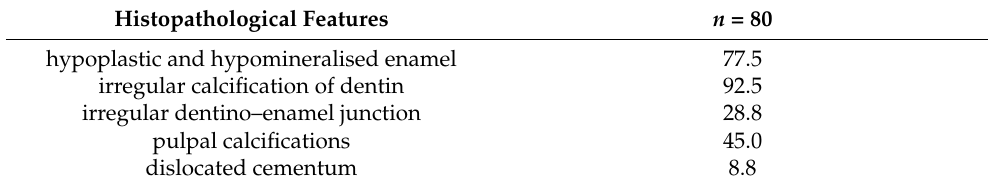
Table 5. Histopathological features in patients with regional odontodysplasia (%). Histopathological